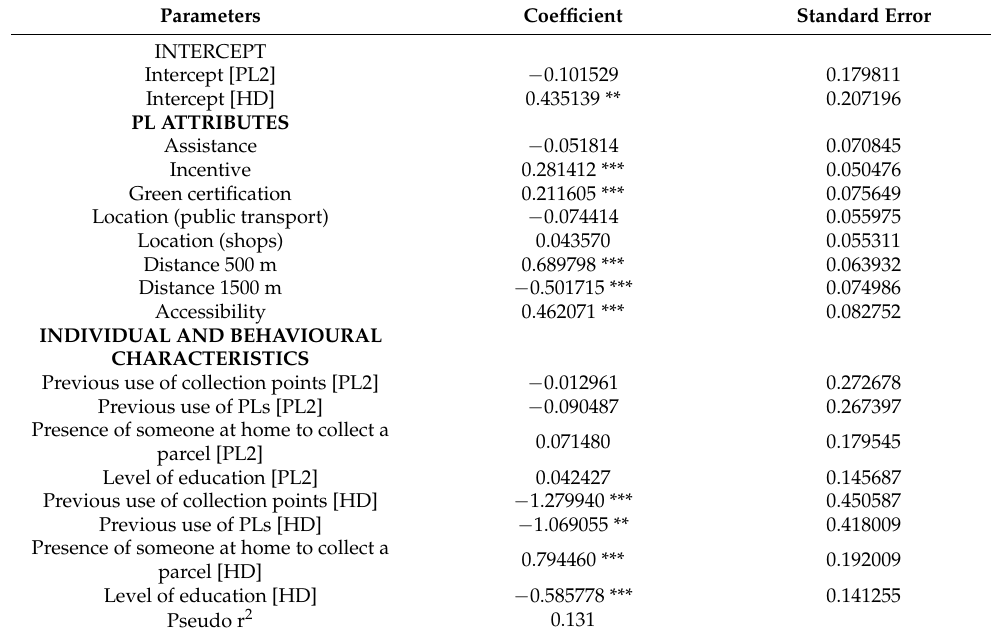
Table 2. MNL results